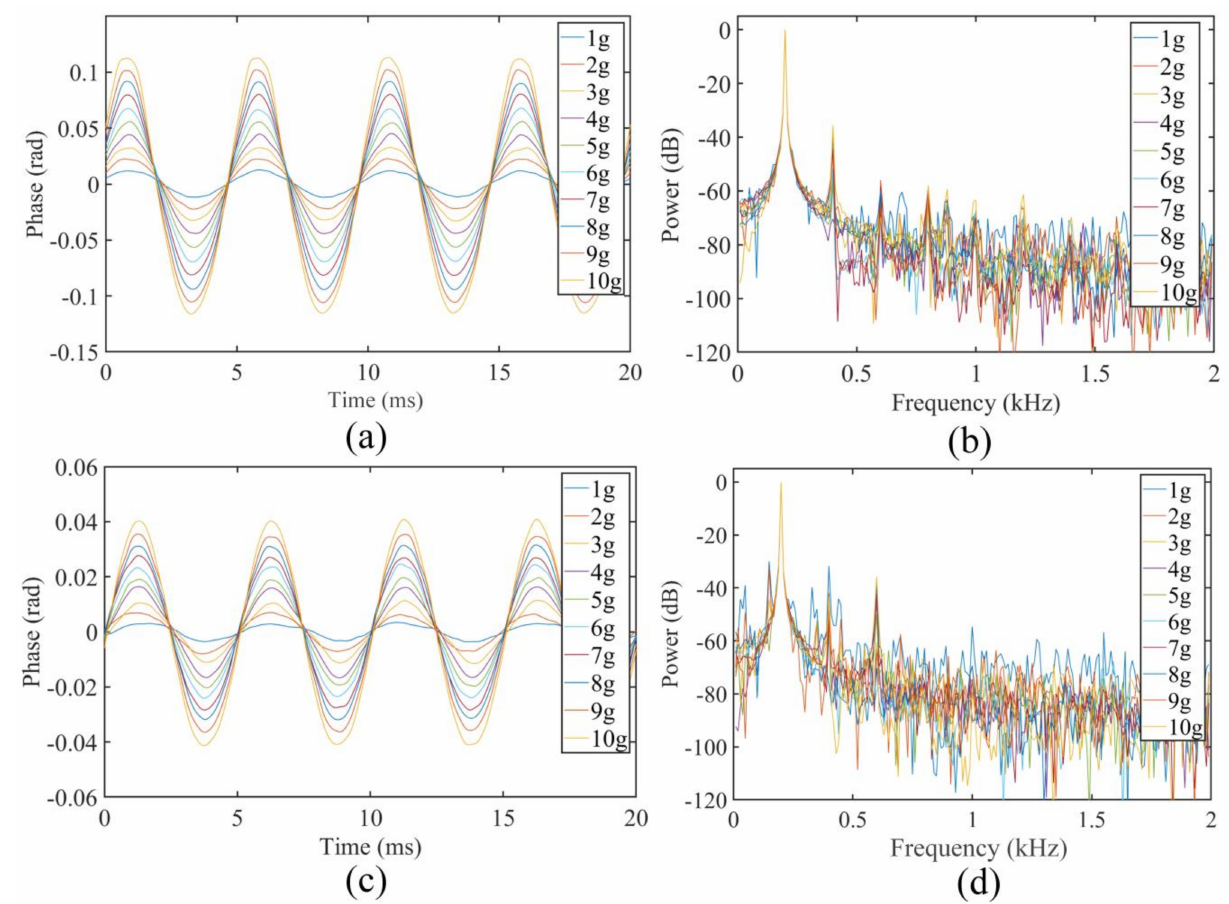
Figure 4. Output of the sensor from 1 g to 10 g under 200 Hz at 20 ◦ C and 800 ◦ C: ( a ) waveform of the sensor at 20 ◦ C, ( b ) frequency response of the waveform at 20 ◦ C, ( c ) waveform of the sensor at 800 ◦ C. ( d ) frequency response of the waveform at 800 ◦ C.